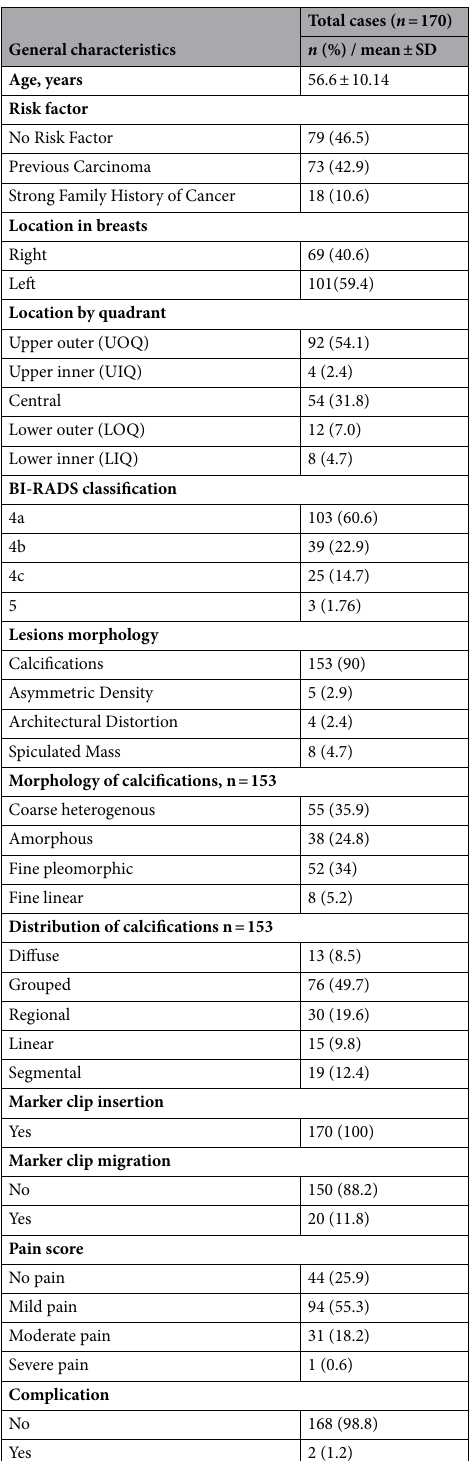
Table 1. Demographic and lesion’s